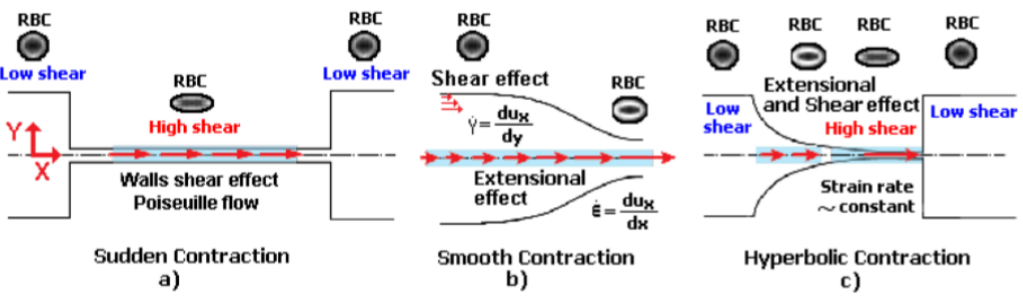
Figure 1. Blood flow and RBC deformability in microfluidic contractions at different geometries: ( a ) sudden contraction; ( b ) smooth contraction; and ( c ) hyperbolic contraction, adapted from